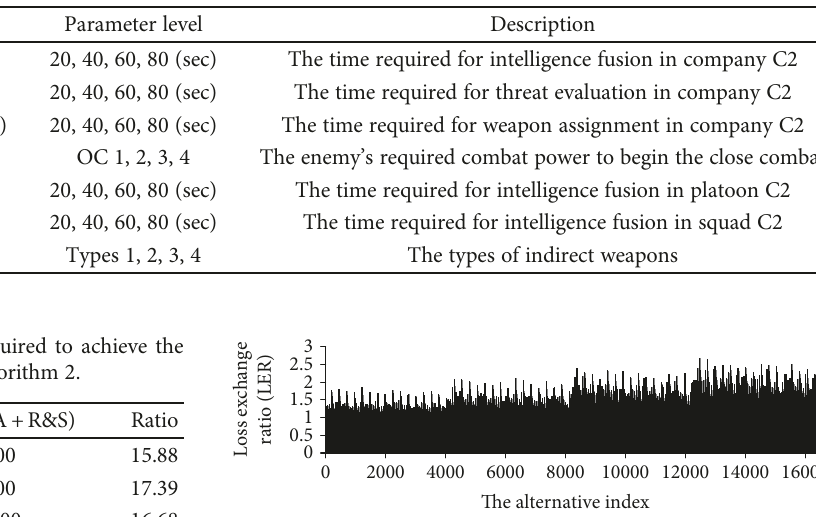
Table 1: Combat model parameters and their